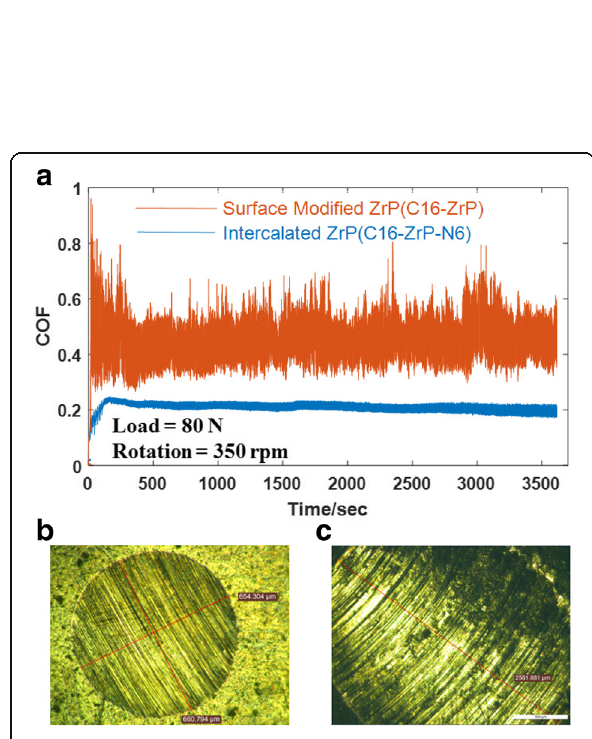
Fig. 8 a Friction coefficients of the nanolubricating oils containing C16-ZrP and C16-ZrP-N6 under a load of 80 N and rotation speed of 350 rpm. Optical microscopic images of the wear scar images for b C16-ZrP-N6 and c C16-ZrP in mineral oils after